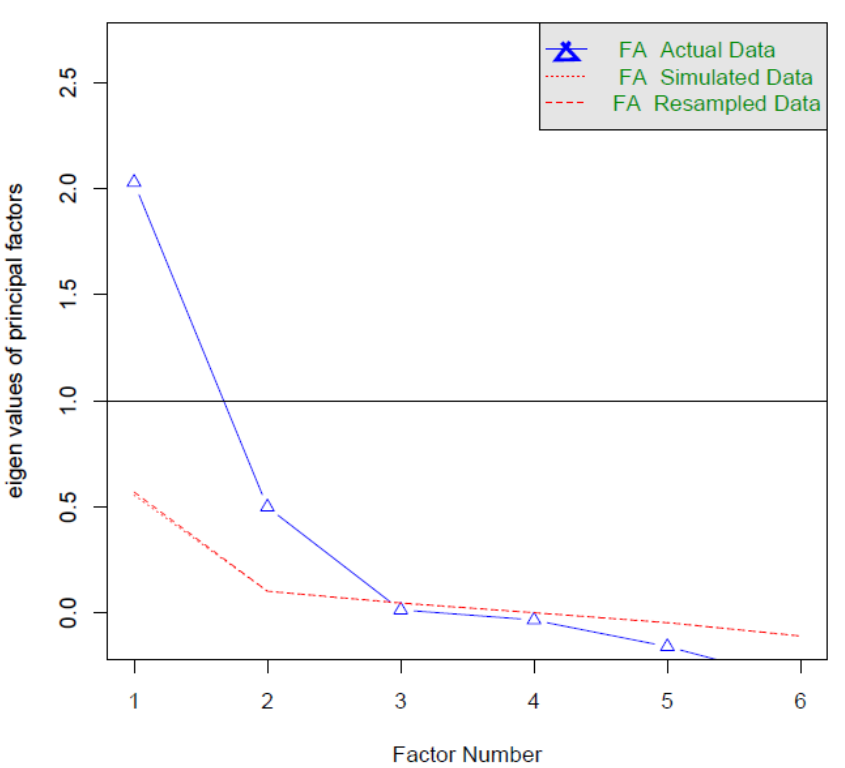
Figure 1. Parallel analysis of the Experienced and Anticipated Sexual Stigma Scale in Health-care Services. Two factors are recommended with the principal axis functioning extraction using 1000 simulated samples. Table 3. Factor loadings of the Experienced and Anticipated Sexual Stigma Scale in Health-care